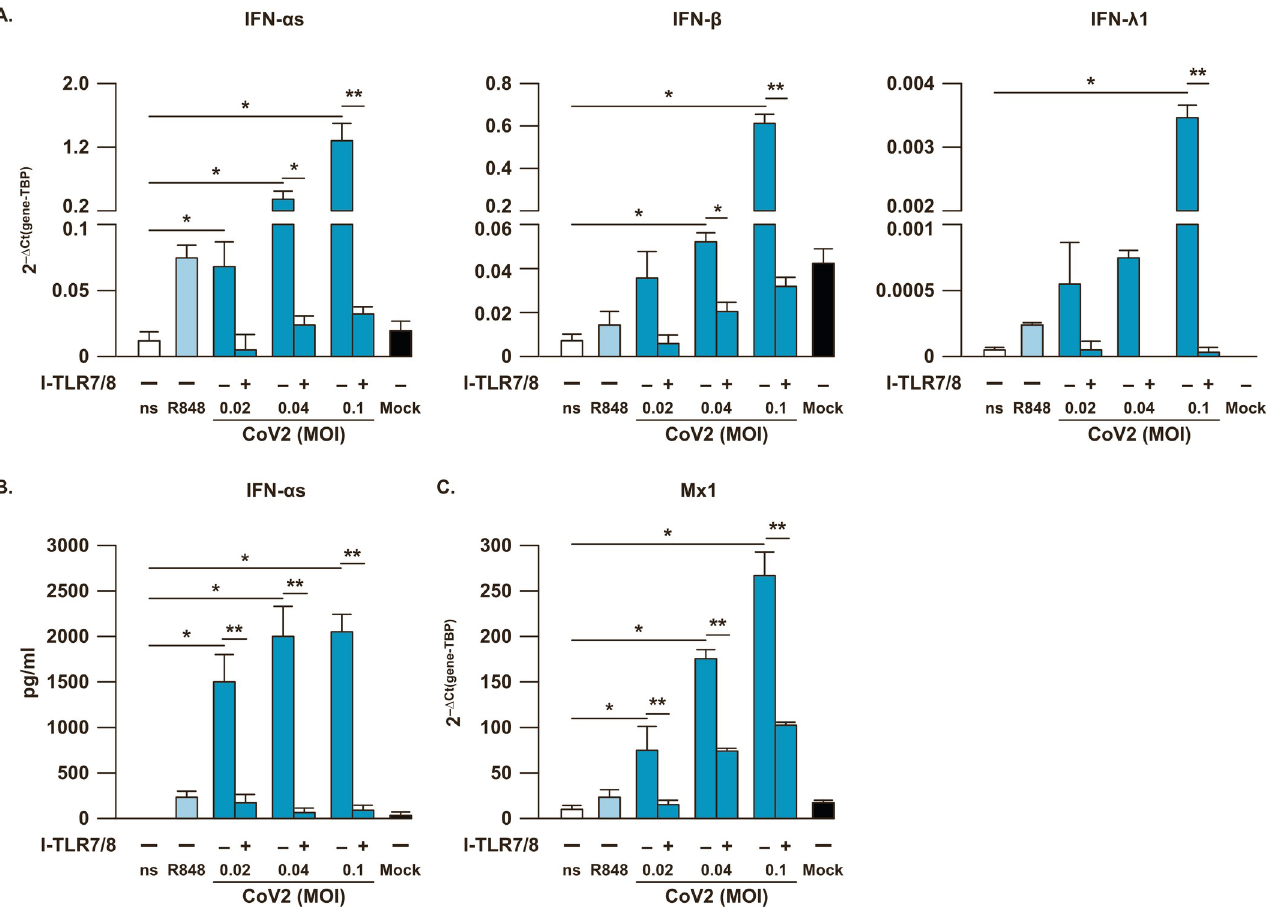
Fig 1. SARS-CoV-2 stimulation induces a TLR7/8-dependent type I and III IFN response in PBMC. Peripheral blood mononuclear cells (PBMC) were left untreated (not stimulated, ns) or Mock-treated as negative controls, or stimulated for 24 hours with the TLR7/8 agonist R848 (5 μ M) as positive control, with SARS-CoV-2 (CoV2) at different multiplicity of infection (MOI; 0.02, 0.04 and 0.1) in presence or absence of a 30 minute pre-treatment with a specific TLR7/8 inhibitor (I-TLR7/8, 1 μ M). ( A ) Relative expression of IFN- α s, IFN- β , IFN- λ 1 genes was measured by quantitative real time PCR analysis. All quantification data were normalized to TBP level by using the equation 2 - Δ Ct . ( B ) Production of IFN- α s was tested by specific ELISA in 24 hour-collected cell culture supernatants. ( C ) Mx1 gene expression was quantified by real time PCR as described above. Shown results were mean relative values ± SEM of 5 independent experiments. P- values were depicted as follows: � p � 0.05; �� p �